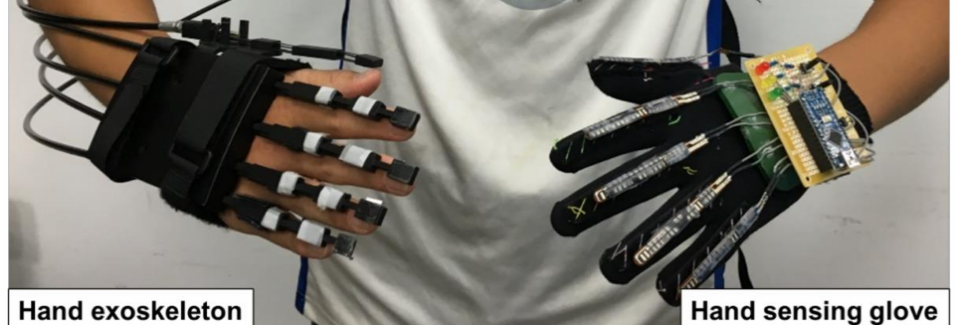
Figure 1. Framework of the bilateral hand practice, including a hand exoskeleton and a hand-sensing glove.